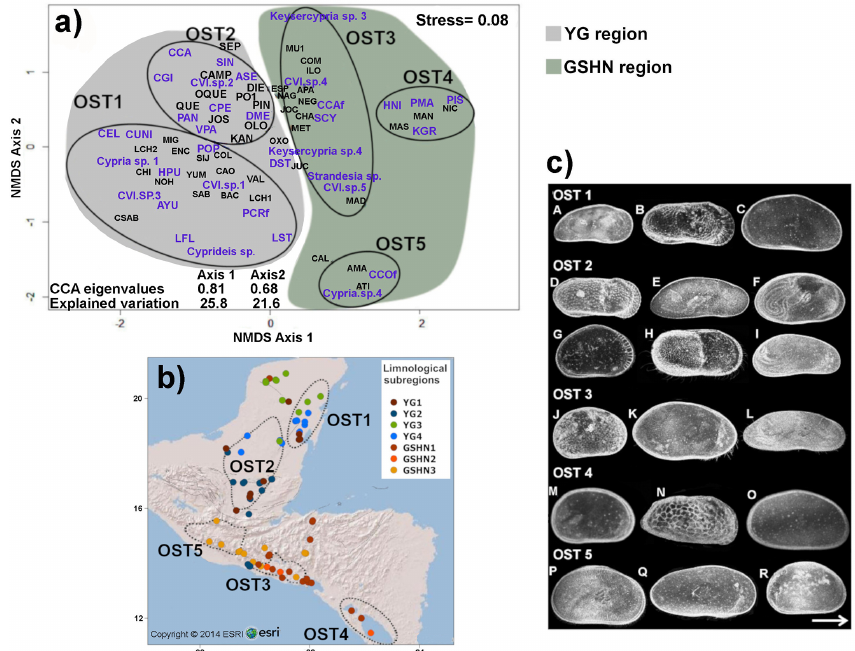
Figure 5. (a) Non-metric multidimensional scaling (NMDS) plot showing differences in ostracode species composition among the 76 studied aquatic ecosystems. Results are based on the Bray–Curtis dissimilarity index, using species presence–absence data (stress = 0 . 08). Black lines indicate ostracode group associations (OST 1–5). For species name abbreviations see Table S3. (b) Map showing spatial distribution of species associations. (c) Plate of selected freshwater ostracode species of each limnological subregion of the northern Neotropical region. (A) Thalassocypria sp.; (B) Limnocythere floridensis ; (C) Heterocypris punctata ; (D) Paracythereis opesta ; (E) Diaphanocypris meridana ; (F) Strandesia intrepida ; (G) Cypretta maya ; (H) Cytheridella ilosvayi ; (I) Pseudocandona antilliana ; (J) Keysercypria sp. 4; (K) Strandesia sp.; (L) Stenocypris cylindrical major (M) Physocypria granadae ; (N) Perissocytheridea cf. cribrosa ; (O) Heterocypris nicaraguensis ; (P) Hemicypris sp.; (Q) Pseudostrandesia sp.; (R) Cypria sp. 4.